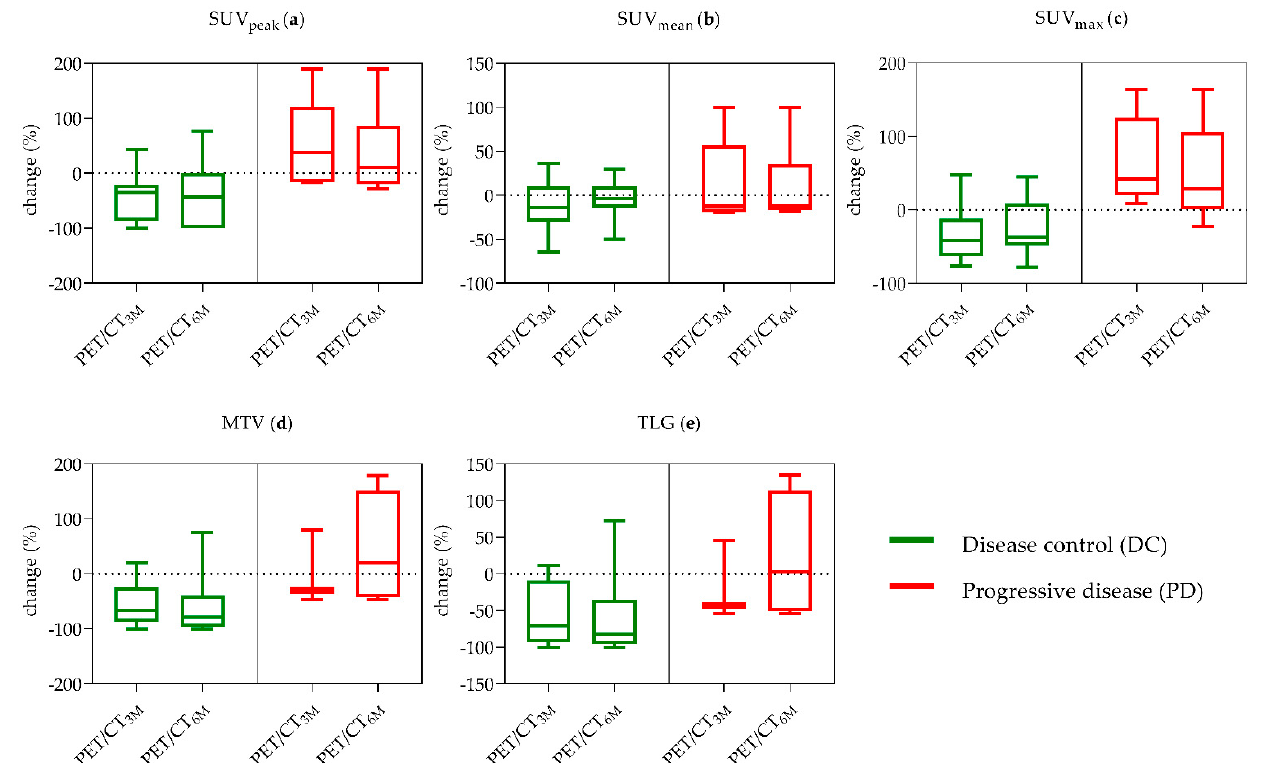
Figure 2. Mean changes of PET-parameters ( a ) SUV peak , ( b ) SUV mean , ( c ) SUV max , ( d ) MTV and ( e ) TLG in patients with DC and PD according to RECIST from baseline to 3 and 6 month follow-up imaging. 3M, 3 months; 6M, 6 months; DC, disease control; PD, progressive disease; SUV, standard uptake value; MTV, metabolic tumor volume; TLG, total lesion glycolysis.